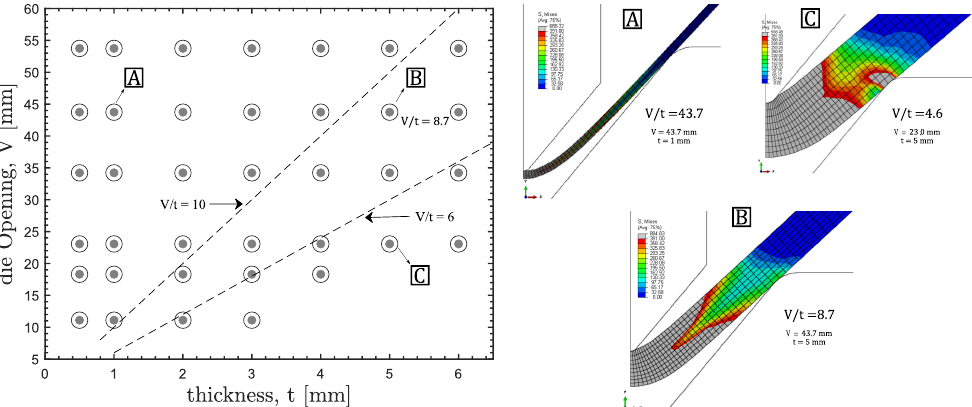
Figure 4. V - t diagram: combinations of tested V and t values (points) and limits (straight lines) representing industrial practice reference